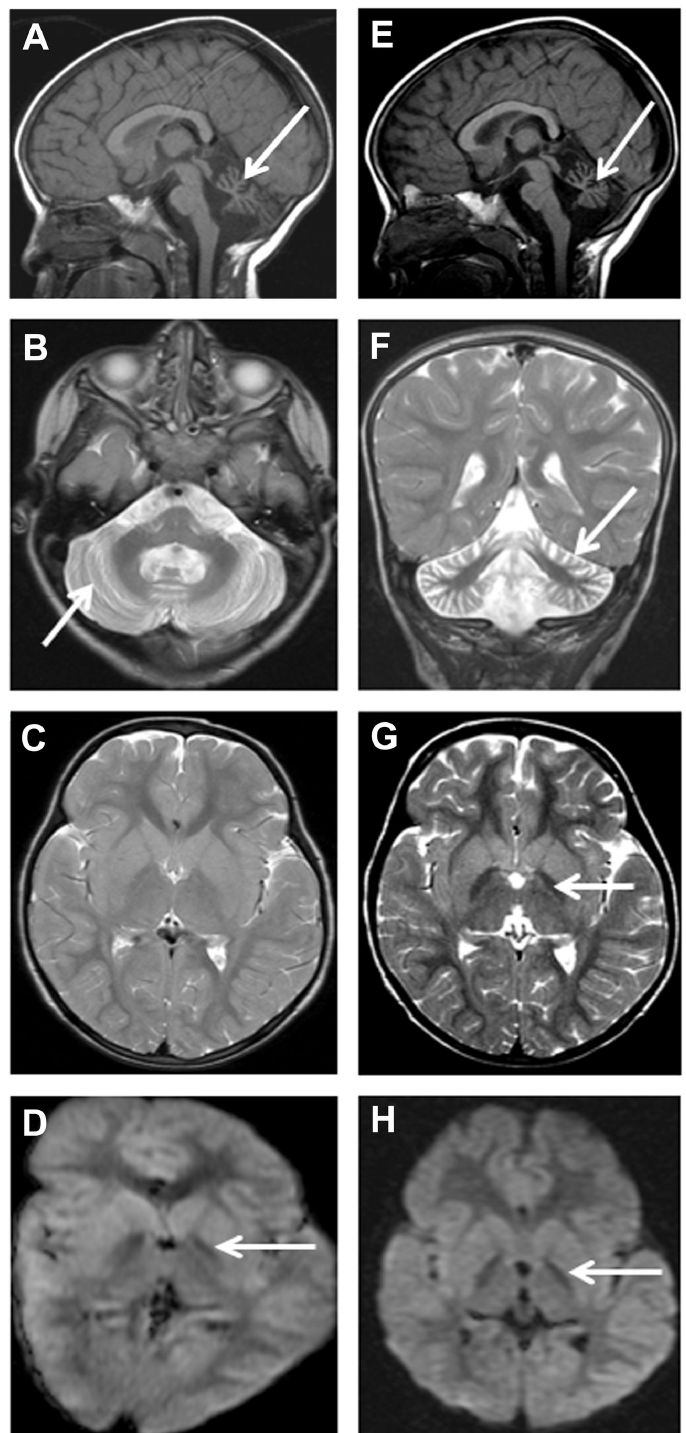
Figure 4. Patient F1 (P1) MRI, age 3 years 1 month (A-D), and 4 years 2 months (E-H). There is increased CSF space around the cerebellum (arrows in A and E) associated with cerebellar cortical atrophy and gliosis, with widening of folia and increased signal in the residual cerebellar cortex (arrows in B and F). Axial T2-weighted (C and G) and axial diffusion (D and H) highlight iron deposition as reduction in signal intensity in the globus pallidi in only the later T2-weighted sequence (G), but in both diffusion sequences (D and H). doi: 10.1371/journal.pone.0076831.g004 PLOS ONE |